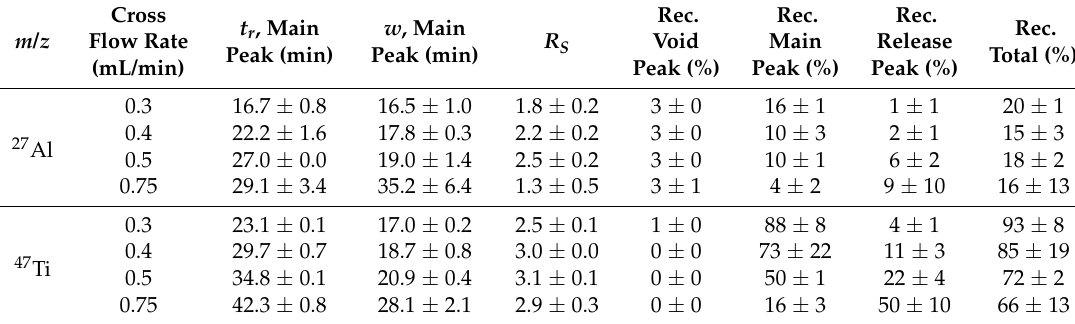
Figure 3. Influence of cross flow rate on the AF4 fractionation of the toothpaste particles (10 μ g injected mass): ( a ) 27 Al signal, ( b ) 47 Ti signal. All AF4 ‐ ICP ‐ MS measurements were performed on the same membrane. Signal smoothing was applied. Table 2. Experimental parameters determined for the 27 Al and 47 Ti signals at different cross flow rates (N = 2, where N is the number of repeated measurements). Retention times ( t r ), peak width ( w ), calculated resolution for the void and main peak ( R S ), and obtained AF4 recoveries.